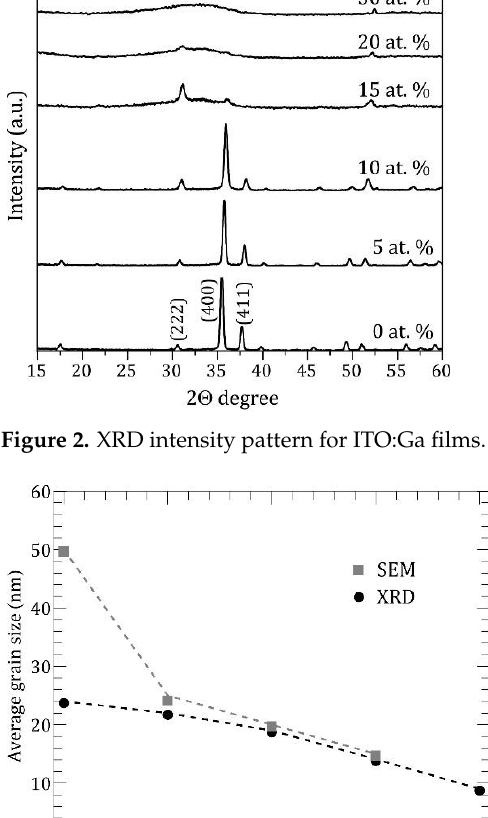
Figure 2. XRD intensity pattern for ITO:Ga films.